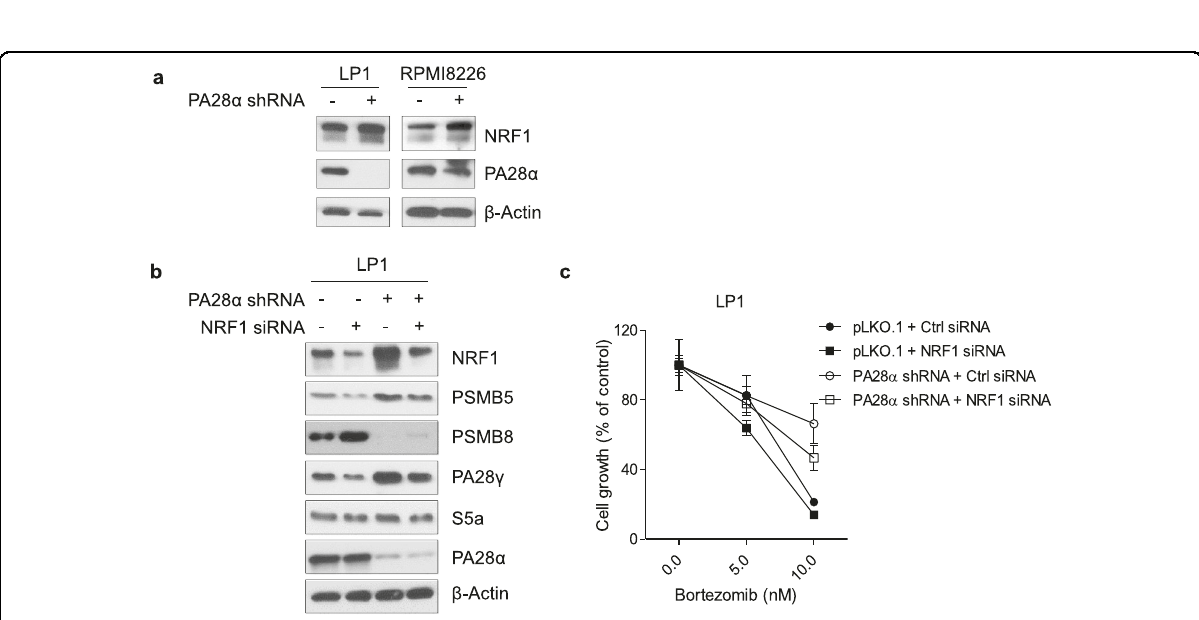
Fig. 5 Silencing NRF1 reverses PA28 α knockdown-induced proteasome recovery and resensitizes to bortezomib treatment. a Western blot analysis of NRF1 in LP1 and RPMI8226 PA28 α knockdown and control stable cells. b LP1 PA28 α knockdown and control stable cells were transiently transfected with NRF1 siRNA or control siRNA. 48 h after transfection, cell lysates were collected and analyzed for expression of proteasome subunits by western blot ( b ) or cells were treated with different concentrations of bortezomib for 24 h, MTT assay was performed to assess relative cell growth ( c